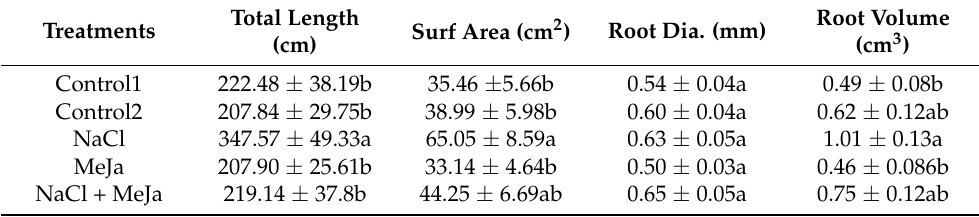
Table 1. Root growth parameters (length, surface area, average diameter, and root volume) of C. maritimum plants grown under hydroponic conditions with the following treatments: control1, Control2, NaCl, MeJa, NaCl + MeJa, ( n = 20). Columns with different letters (a, b) for each variable differ significantly according to Tukey’s test ( p < 0.05).